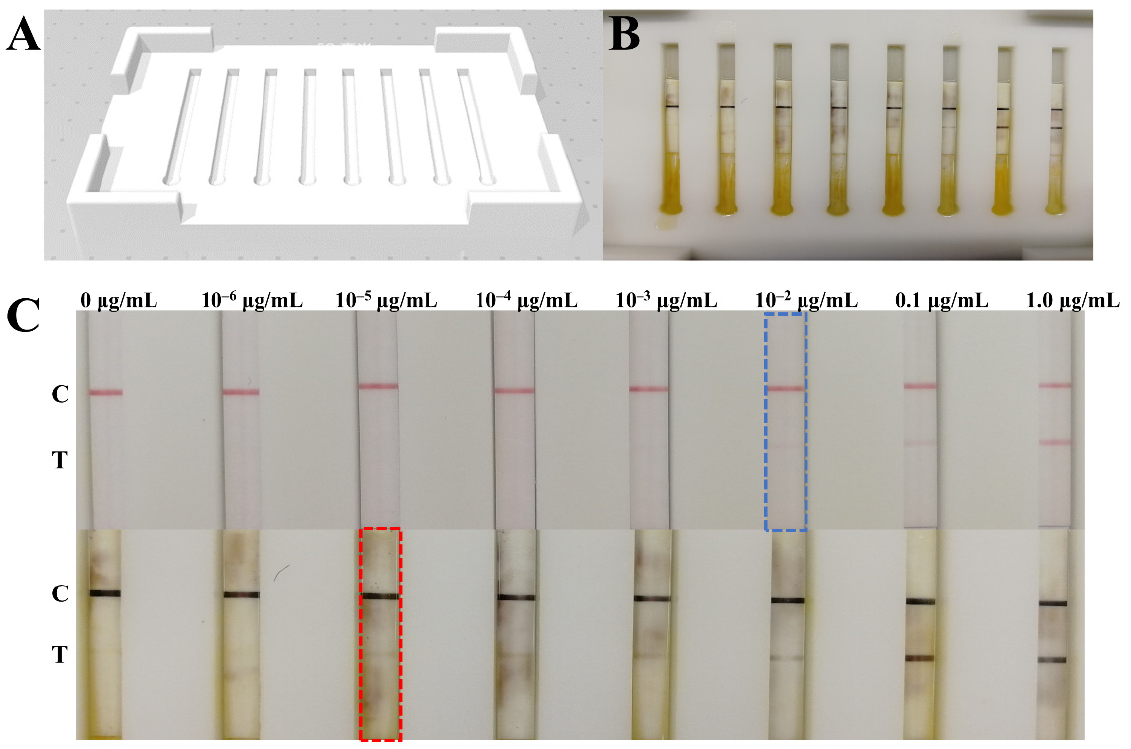
Figure 5. Simple device for copper deposition signal amplification ( A , B ); detection of NP antigen standard solutions before and after signal amplification ( C ). Table 1. Comparison of the performances among the developed method and other reported meth- ods for SARS-CoV-2 NP antigen detection.